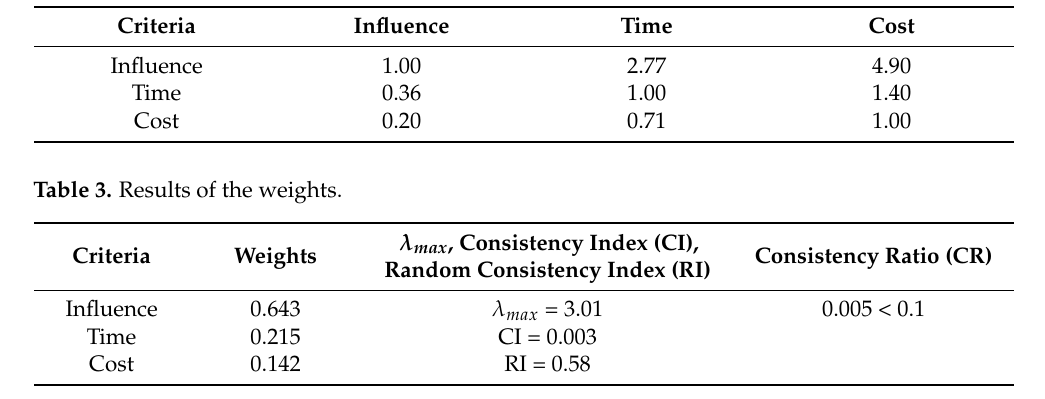
Table 2. Group pairwise comparison matrix for criteria.